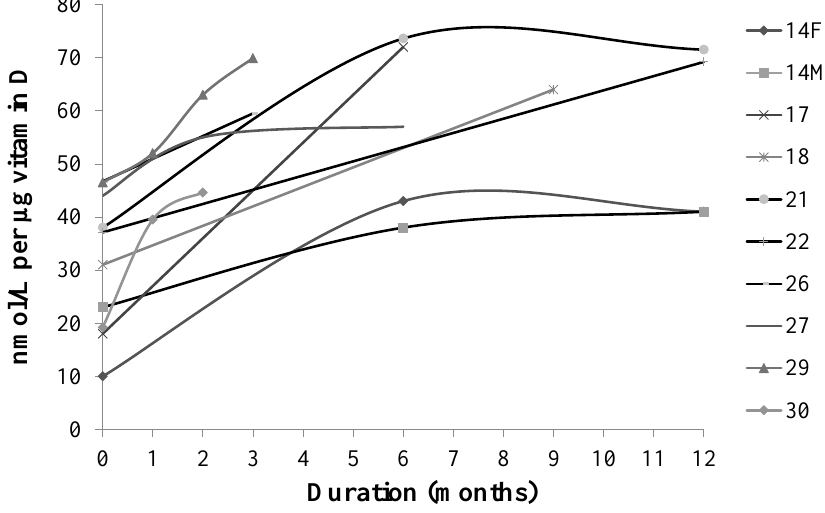
Figure 1. Graph depicts association between rate constant of synthesis of 25-hydroxyvitamin D from its precursor (vitamin D) by dose of vitamin D administered in randomized controlled trials [13–30].